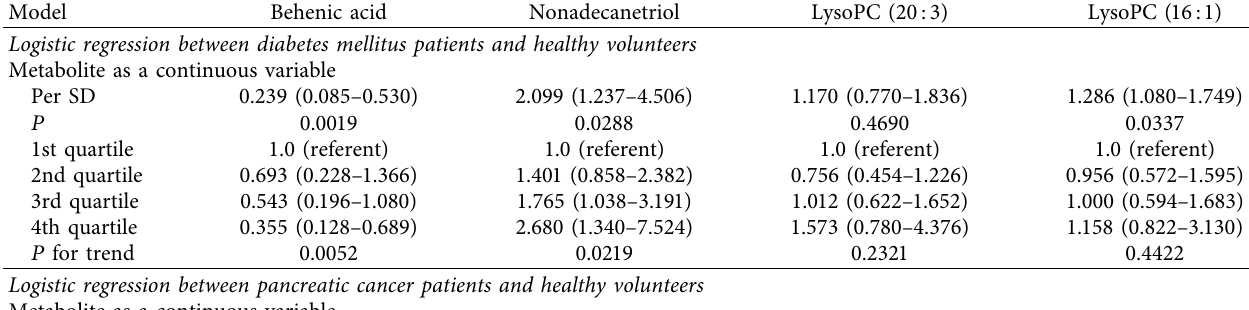
Table 3: Relation of specific metabolites to risk of future diseases (diabetes mellitus and pancreatic cancer). Model